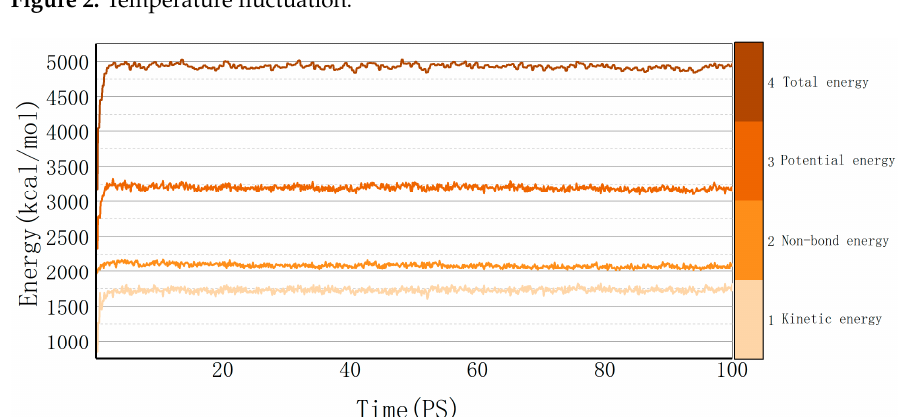
Figure 3. Energy fl uctuation.